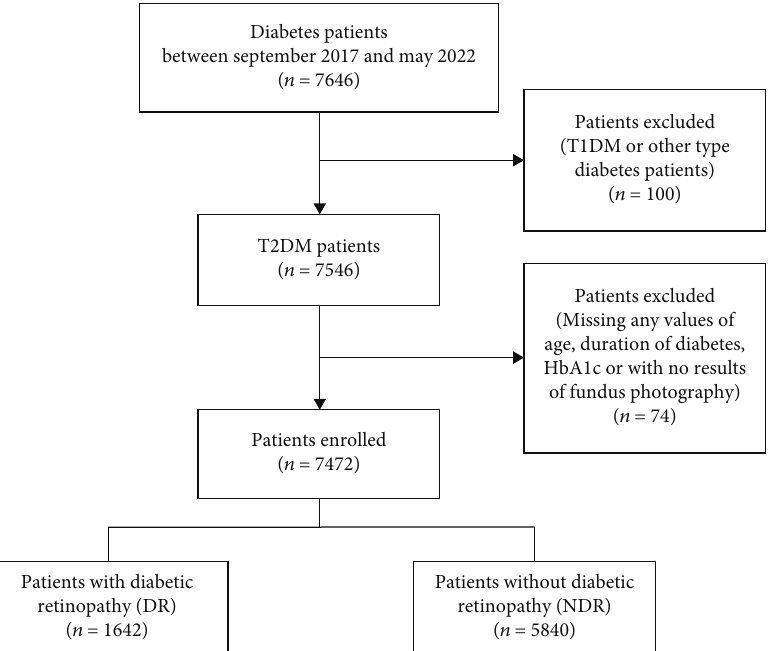
Figure 1: Flowchart of the study. Abbreviations: T1DM: type 1 diabetes mellitus; T2DM: type 2 diabetes mellitus; HbA1c: glycated